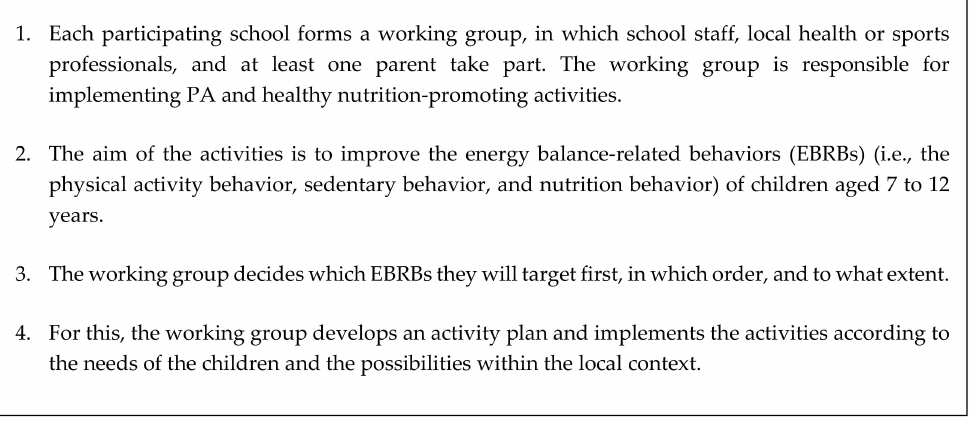
Figure 1. Basic intervention principles as provided by the steering